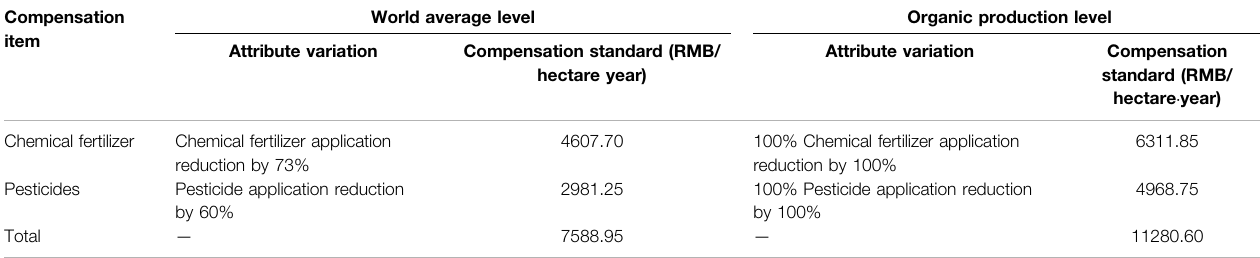
TABLE 5 | Compensation standards for different restoration